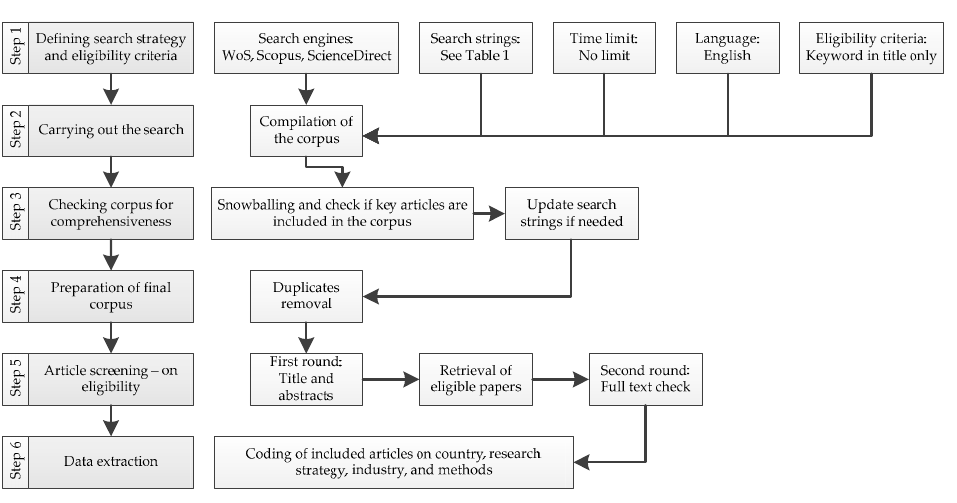
Figure 2. Overall research process scheme (adapted from [23]) .